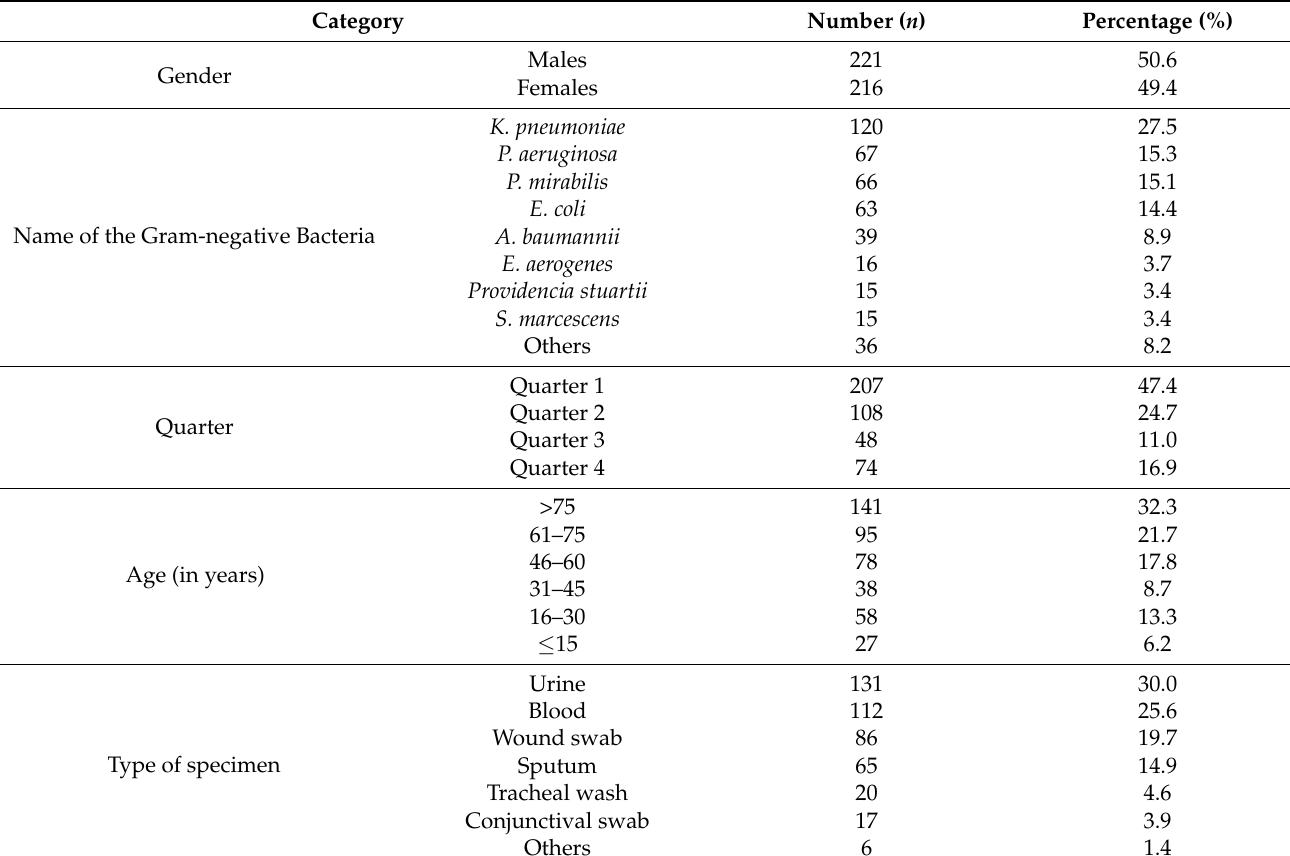
Of the 437 Gram-negative infections, 221 (50.6%) occurred in males, and 141 (32.3%) in patients aged more than 75 years. Nearly half (47.7%) of the bacterial isolations were recovered in the first quarter. Urine specimens (131; 30.0%) dominated the frequency of Gram-negative bacterial growths, followed by blood specimens (112; 25.6%). The majority of the infections were caused by K. pneumoniae (27.5%) (Table 2 and Figure 1). Table 2. Distribution of Gram-negative bacteria isolated from ICU clinical specimens ( n = 437).